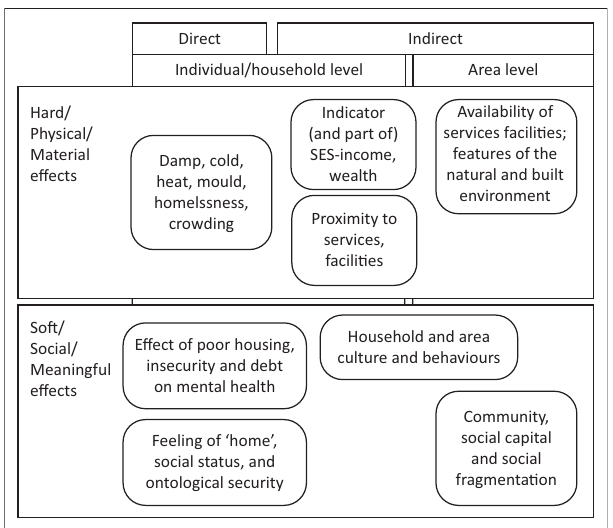
FIGURE 1: Direct and indirect ways in which housing can affect